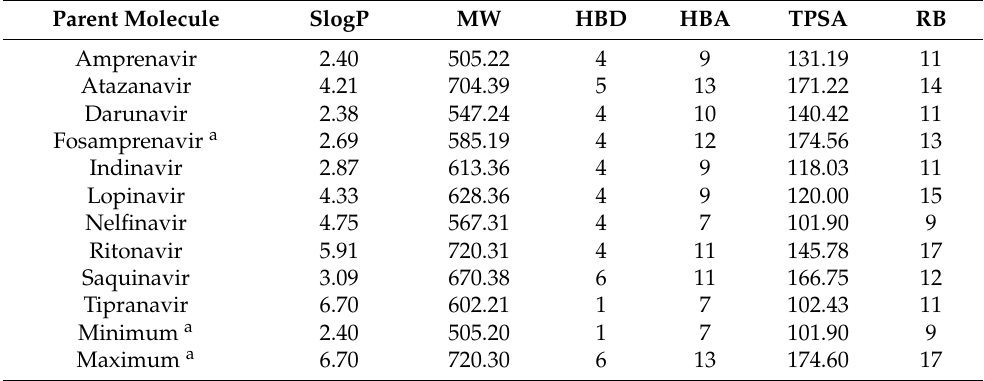
Table 4. Properties of pharmaceutical relevance of FDA-approved HIV-1 protease